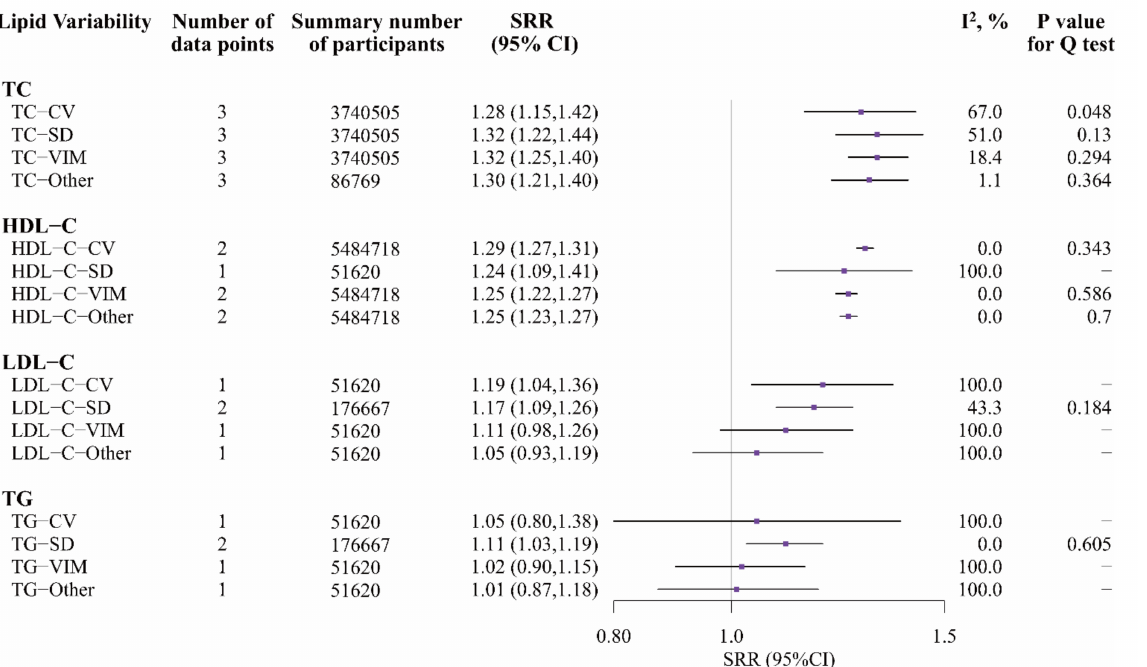
Figure 3. Random-effects meta-analysis of standardized RRs for different types and metrics of LV (top vs. bottom quartile) and all-cause mortality. Notes: If data were reported based on subgroups of CVDs, they were treated as different data points. LV, lipid variability; TC, total cholesterol; HDL-C, high-density lipoprotein cholesterol; LDL-C, low-density lipoprotein cholesterol; TG, triglycerides; CV, coefficient of variation; SD, standard deviation; VIM, variation independent of mean; TC-Other included average real variability of TC (TC-ARV), average successive variability of TC (TC-ASV) and root mean square error of TC (TC-RMSE); HDL-C-Other included average real variability of HDL-C (HDL-C-ARV); LDL-C-Other included average real variability of LDL-C (LDL-C-ARV); TG-Other included average real variability of TG